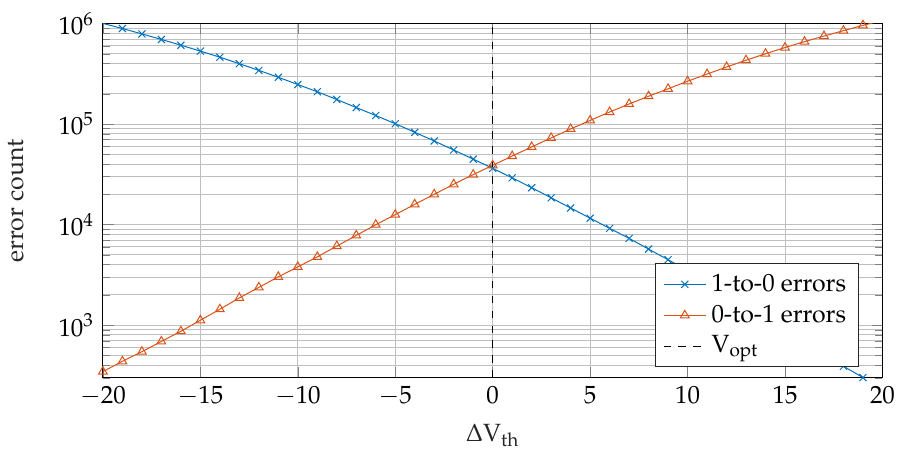
Figure 4. Error count for 1-to-0 errors and 0-to-1 errors versus the threshold voltage for r 3 at EOL. As shown in Figure 2, the higher distributions are highly asymmetric for early-life cases. Figure 5 shows the error count for 1-to-0 errors, 0-to-1 errors, and the overall error count for reference r 7 for a fresh memory block. The error probabilities are asymmetric at the optimal threshold voltage indicated by the value ∆ V th = 0, which needs to be considered for voltage adaptation.